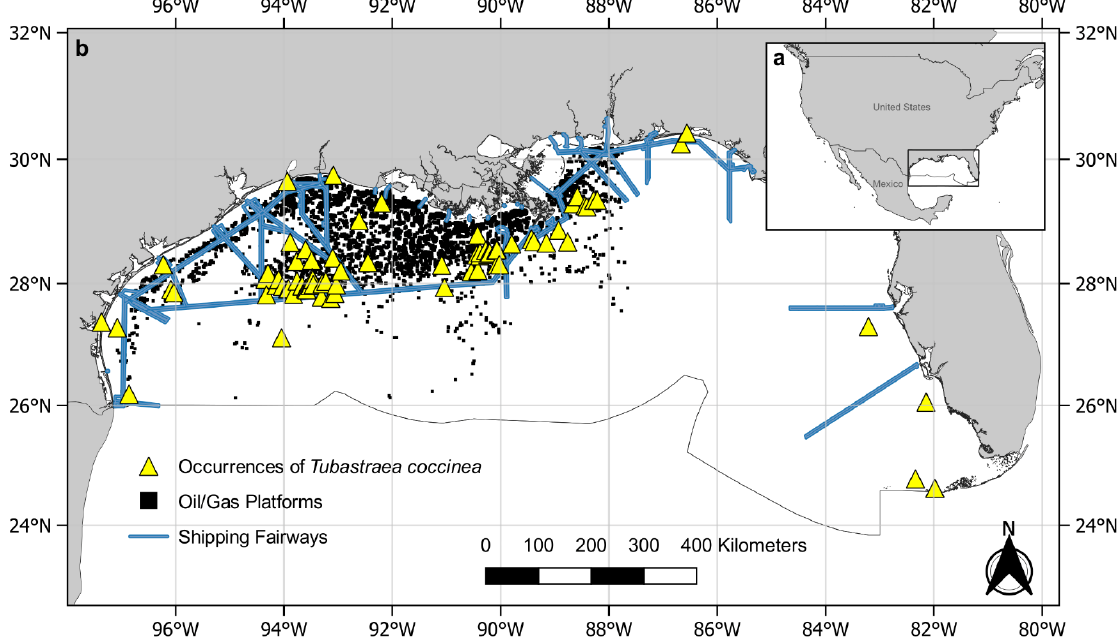
Figure 1. Maps of ( a ) the study area, which includes the exclusive economic zone of the United States within the northern portion of the Gulf of Mexico, and ( b ) the records of Tubastraea coccinea , oil/gas platforms, and lanes of heavy shipping fairways within the northern Gulf of Mexico. Table 1. Units and descriptive statistics for the nine environmental variables and the two anthropo- genic variables. Variable Unit Maximum Mean Minimum Benthic Maximum current velocity